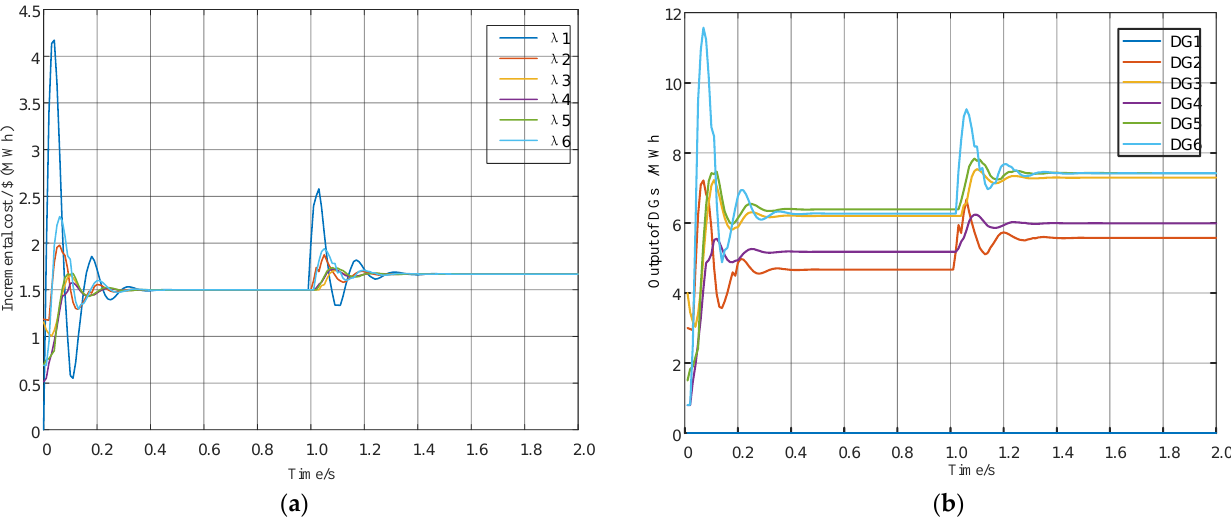
Figure 5. System response with this control strategy at p = 0.9: ( a ) Incremental cost; ( b ) output of DGs.